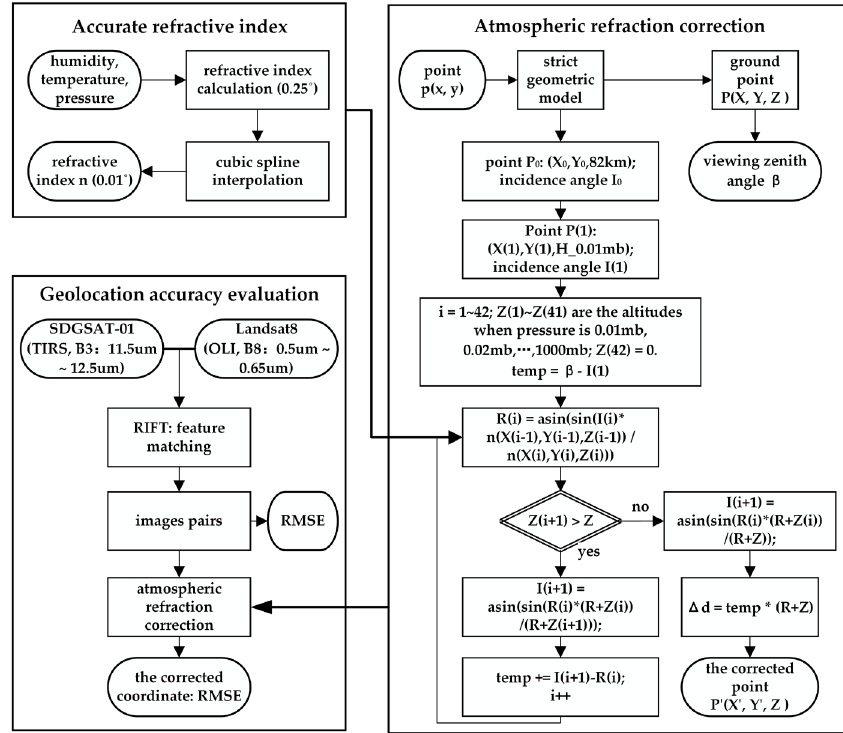
Figure 3. Flowchart of the proposed atmospheric refraction correction method.